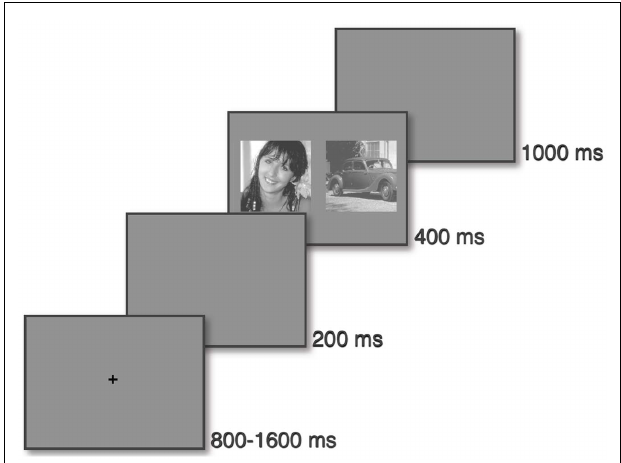
FIGURE 2 | Protocol: the saccadic choice task. A fixation cross is displayed for a pseudo-random time (between 800 and 1600ms), then, after a 200ms gap, two images (a target and a distractor) are displayed on the left and right. After a 1000ms period, a new trial can